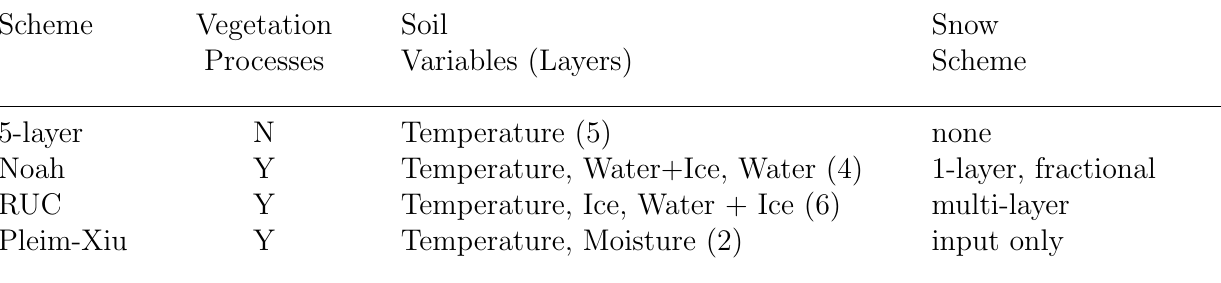
Table 8.3: Land Surface